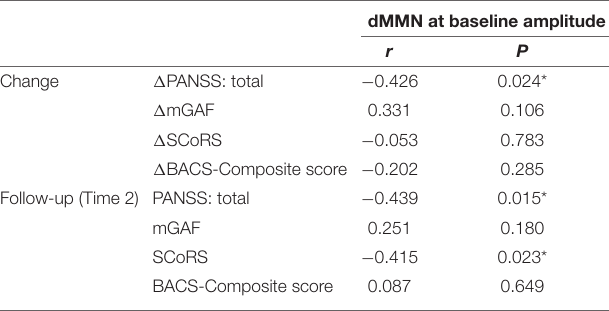
TABLE 4 | Relationships between baseline MMN parameters and clinical, cognitive, and social